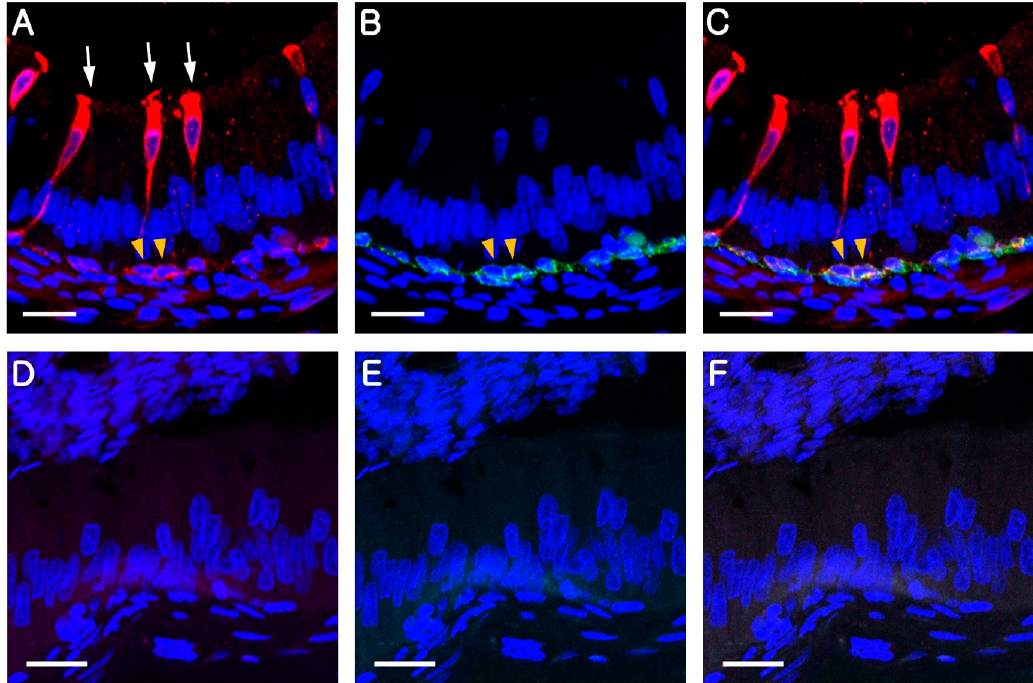
Figure 1. Immunolocalization of B1-VATPase (red) and KRT5 (green) in the epididymis of goat at postnatal month (PNM) 14. ( A ) Epididymis section labeled with anti-B1-VATPase. Goblet-shaped clear cells (CCs) were observed (arrows). ( B ) Epididymis section labeled with anti-KRT5. BCs were located at the base of the epithelium (arrowheads). ( C ) BCs were double labeled for B1-VATPase and KRT5 (arrowheads). ( D–F ) Negative controls showed no B1-VATPase or KRT5 staining in the epididymis. The nuclei were labeled with DAPI (blue). Bars = 20 µm.